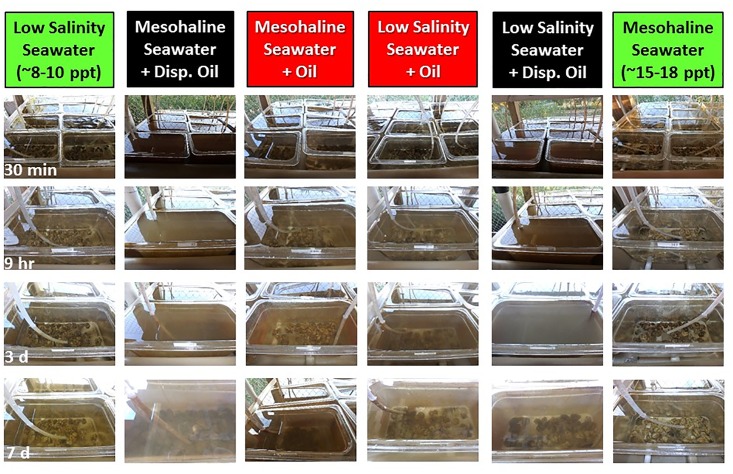
Changes to water clarity with oil and oil+dispersant additions.Photographic representation of visual observations for each treatment system during the experiment. Photos are provided for 30 min, 9 h, 3 d and 7 d after oiling. All photographs are from individual tanks on the bottom shelf of the unit (closest to the sump tank and pump). Treatments are color-coded along the top row of the figure and the time series can be followed down each column.